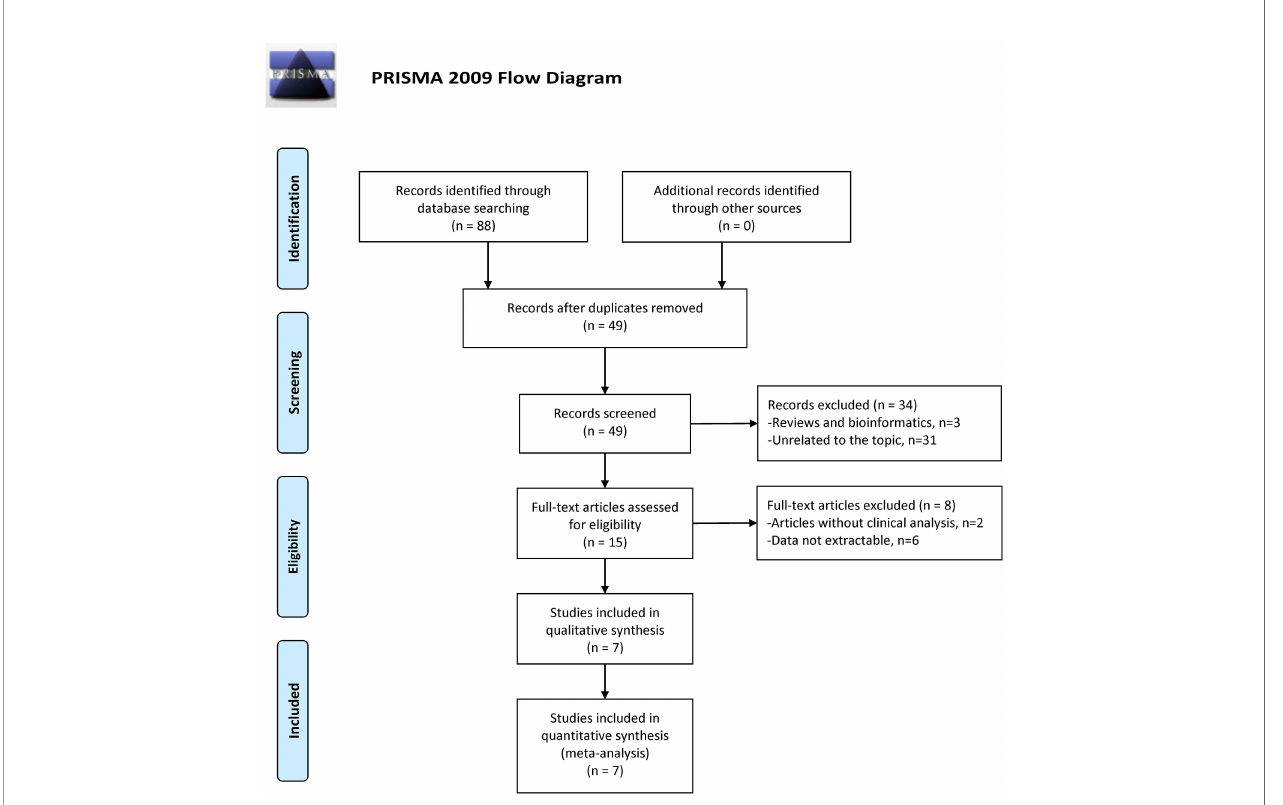
FIGURE 1 | Flow diagram for study identi fi cation with criteria in the meta-analysis